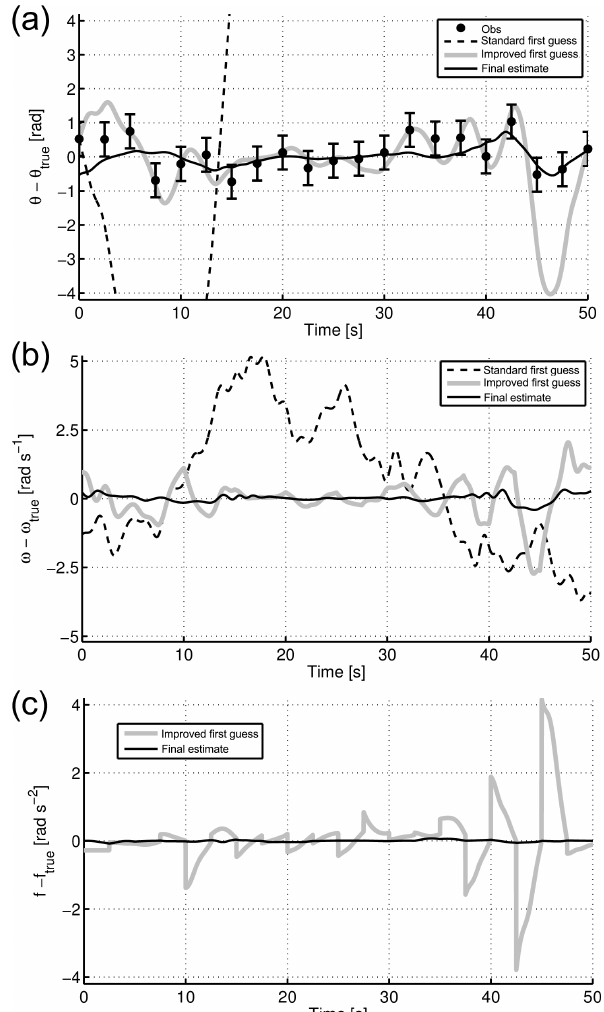
Figure 4. Comparison of the reconstructed pendulum and truth. (a) Difference between the observed (circles), standard first guess (dashed), improved first guess (solid gray line), and final estimate (solid, black line) of pendulum angle relative to the truth. The stan- dard first-guess is off scale for much of the panel. (b) Similar but for angular velocity, ω . (c) Same but for forcing, f . The standard first-guess forcing is suppressed because it is identically